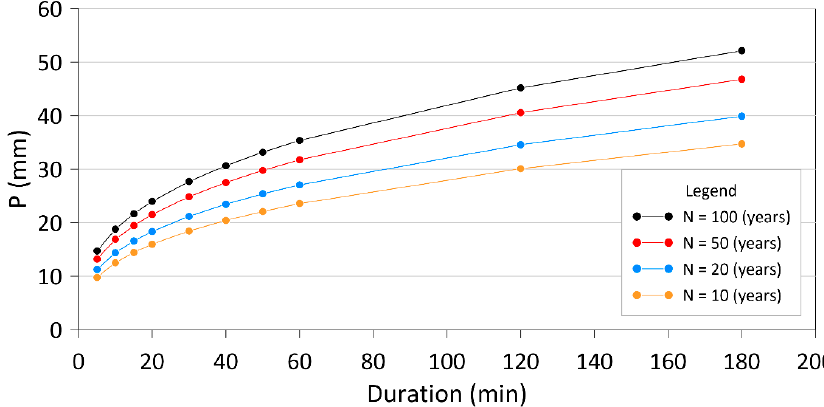
Figure 11. The actual design values of the short-term rainfall for the Vyšná Boca climatological station.